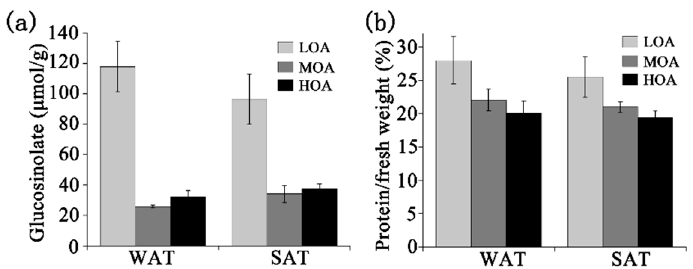
Figure 1. The levels of glucosinolate and protein in LOA, MOA, and HOA cultivars both in WAT and SAT through three annuals with NIRS. Values are means ± SD (n = 3 yr).